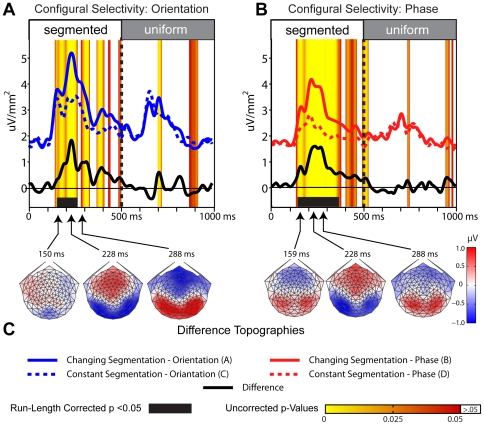
Sensor-space configural selectivity contrasts.Global field power, GFP differences, and corrected and uncorrected significance levels for the (A) orientation-defined and (B) phase-defined configuration contrasts. Changing segmentation (solid), constant segmentation (dashed), and differences (black) waveforms are shown for the orientation- (blue) and phase-defined (red) stimuli. Intervals reaching significance (p = .05) according to run-length corrected permutation tests are indicated by the black bars. Uncorrected significance values are depicted by the red-yellow color scale, starting at p<.05-level. Values higher than the .05-level are plotted as white. (C) Shows the topographic distributions of the difference waves at the three peaks in GFP after figure onset for each of the two configuration contrasts.